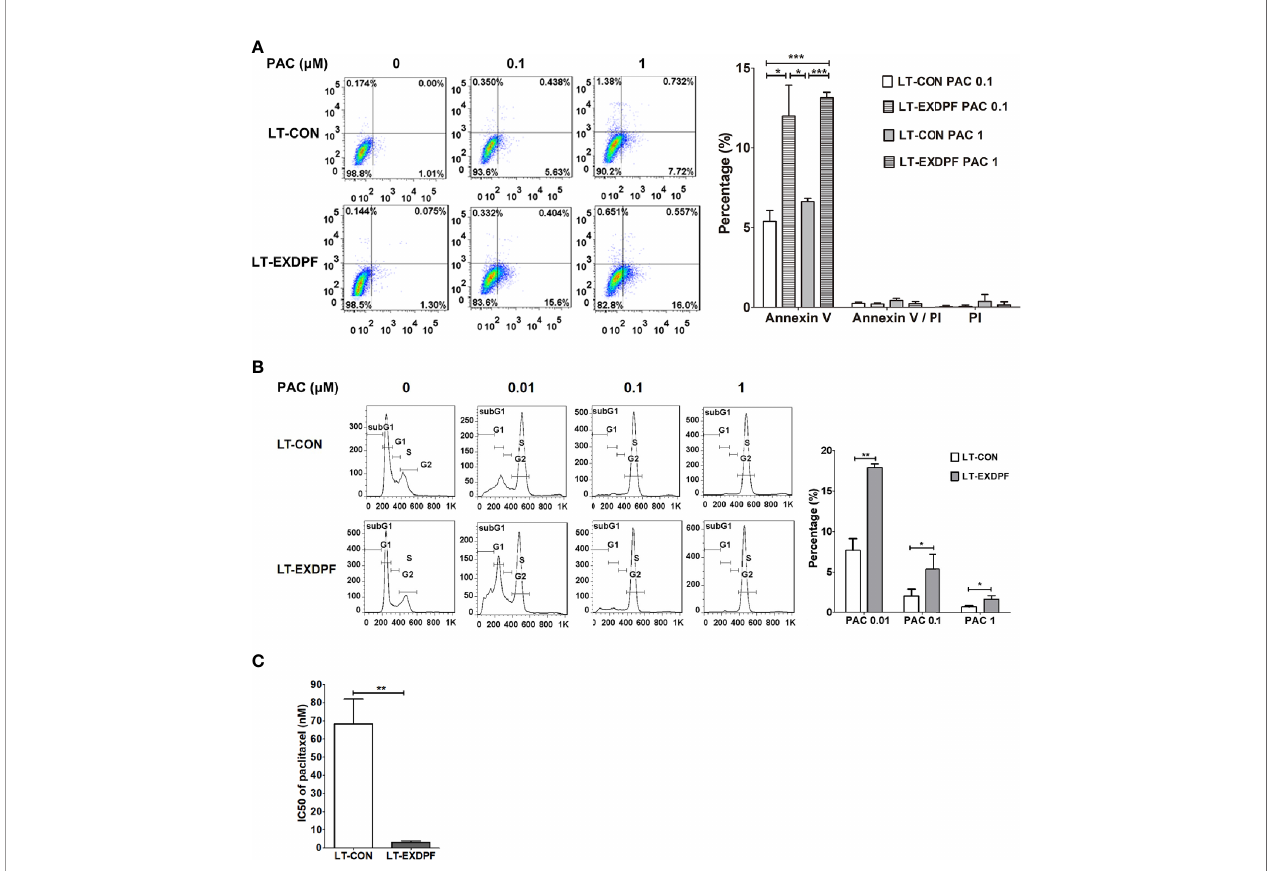
FIGURE 3 | Knock-down of EXDPF sensitized SKOV3 cell to paclitaxel treatment. (A) EXDPF knock-down (LT-EXDPF group) or control (LT-CON group) SKOV3 cells were treated with or without 0.1 or 1 m M paclitaxel (PAC) for 24 h. Cell apoptosis was detected by Annexin V and PI staining assay. Annexin V and/or PI positive cells represent the apoptotic cells. Representative images are shown in the left panel and statistical data are shown in the right panel. LT-CON PAC 0.1: LT-CON cells treated with 0.1 m M paclitaxel. LT-EXDPF PAC 0.1: LT-EXDPF cells treated with 0.1 m M paclitaxel. LT-CON PAC 1: LT-CON cells treated with 1 m M paclitaxel. LT-EXDPF PAC 1: LT-EXDPF cells treated with 1 m M paclitaxel. (B) EXDPF knock-down (LT-EXDPF group) or control (LT-CON group) SKOV3 cells were treated with or without 0.01, 0.1 or 1 m M paclitaxel for 24 h. Cell cycle distribution was detected by PI staining. Representative data and statistical data are shown in the left and right panel, respectively. SubG1, subG1 apoptotic cell phase. G1: G0/G1 phase. S: S phase. G2: G2/M phase. PAC 0.01, PAC 0.1 and PAC 1: cells treated with paclitaxel at the concentration of 0.01, 0.1 and 1 m M, respectively. (C) A total volume of 100 m l culture medium contain 2 × 10 3 EXDPF knock-down (LT-EXDPF group) or control (LT-CON group) SKOV3 cells were seeded into 96 well plates and treated with serial diluted paclitaxel at concentrations from 10,000 to 4.57 nM for 72 h. Cell viability was measured by MTS assay and IC 50 s were calculated. The statistical difference of IC50s between EXDPF knock-down (LT-EXDPF group) and control (LT-CON group) SKOV3 cells was analyzed. Statistic data are presented as mean ± SD. * p < 0.05; ** p < 0.01; *** p <